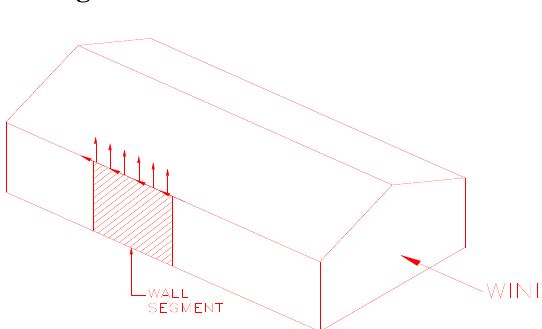
Figure 1. Wind forces on a